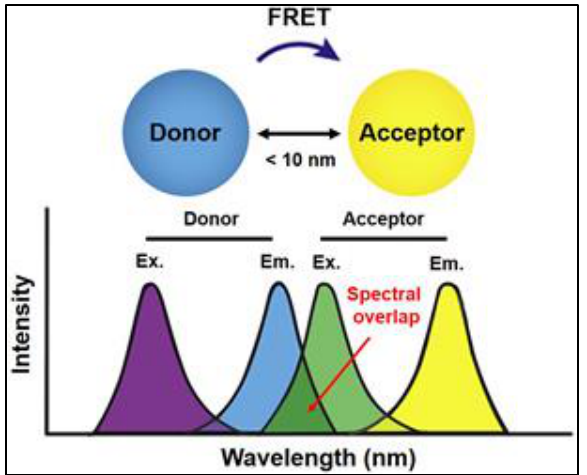
Figure 37. Specific requirements for the detection of FRET signals. The spectra of donor molecule emission ( Em. ) are overlapped with the spectra of acceptor molecule excitation ( Ex. ). The efficiency of FRET appears to be the highest when the energy transferred from Em. to Ex. is fallen within 10 nm in a parallel orientation.